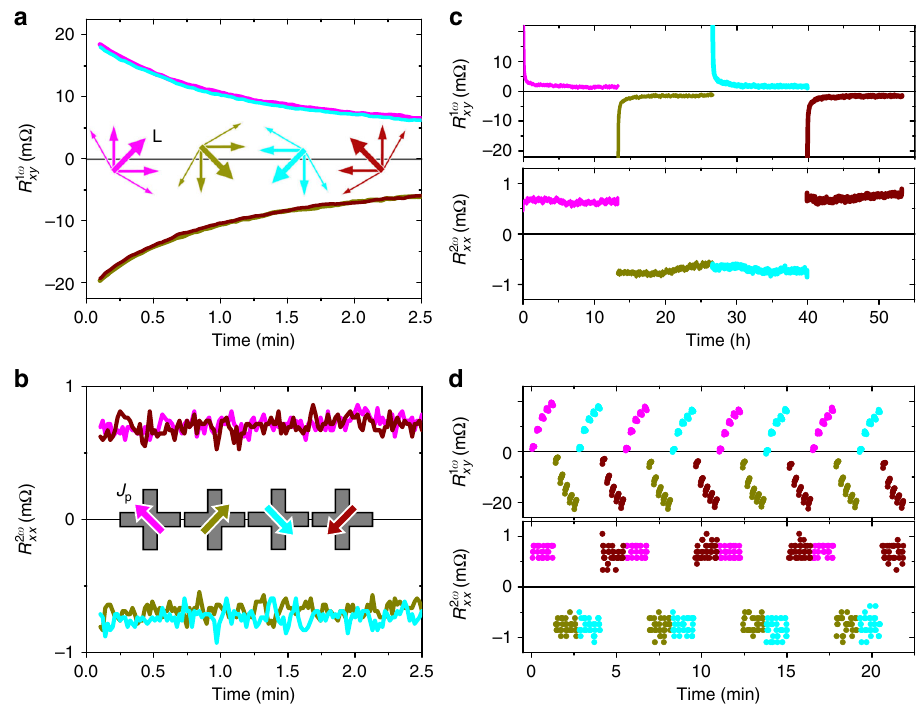
Fig. 5 Time-dependence of fi rst- and second-harmonic signals. a , b First-harmonic R 1 ω xy and second-harmonic R 2 ω xx detection for a sequence of writing current (cid:2) 10 7 A cm − 2 in the cross center. c Same as a , b for 12 h probing measurements pulses along directions rotated by ±45° from the main cross axes with j p after each writing pulse. d First- and second-harmonic signals measured when sending trains of fi ve writing pulses along one direction before changing the pulsing angle. In all panels, probing starts 5 s after the writing